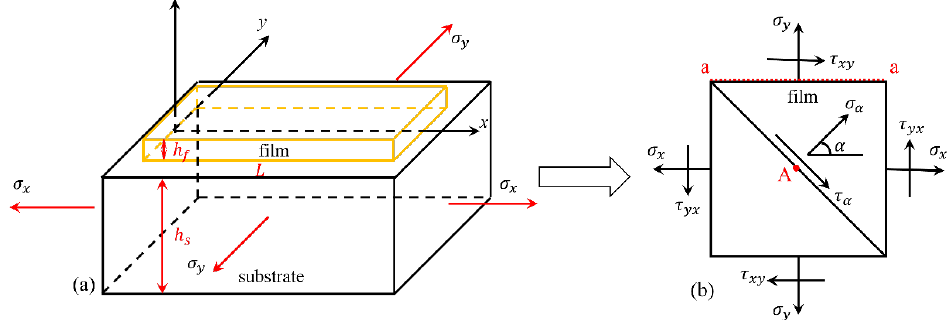
Figure 1. Theoretical model diagram: ( a ) film-substrate structure and ( b ) analysis of the film.